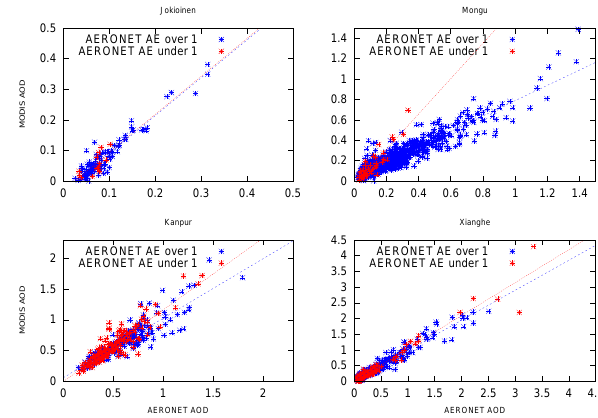
Fig.1. CorrelationofAERONET/PFRandMODISmeasurementsinJokioinen,Mongu,Kanpur andXianghe. BluepointsindicatemeasurementswithMODISAEover1,andredpointsmea- Fig. 1. Correlation of AERONET/PFR and MODIS measurements surements with MODIS AE smaller than 1. Statistics for the comparisons are shown in Table in Jokioinen, Mongu, Kanpur and Xianghe. Blue points indicate 1. measurements with MODIS AE over 1, and red points measure- ments with MODIS AE smaller than 1. Statistics for the compar- isons are shown in Table 1.